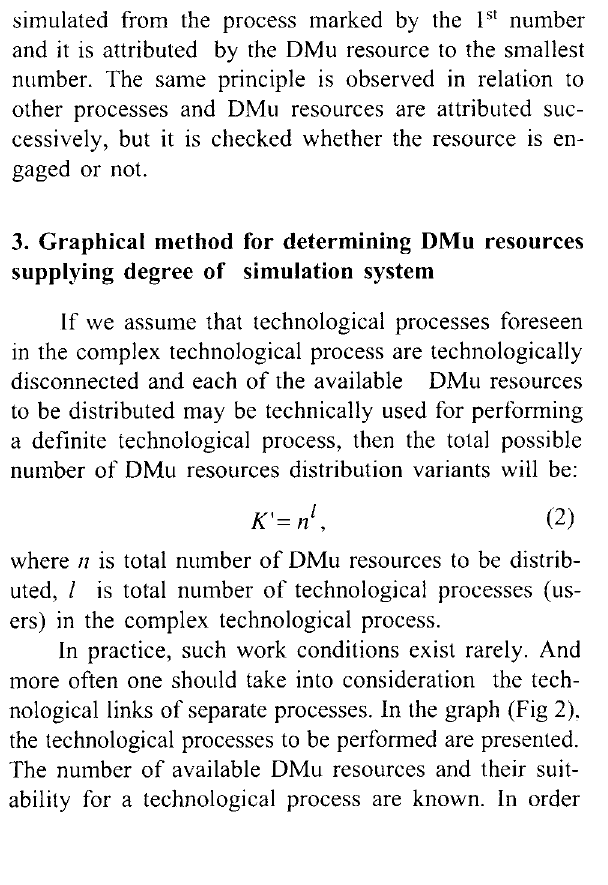
Fig I. Algorithm for simulation of discretional resource